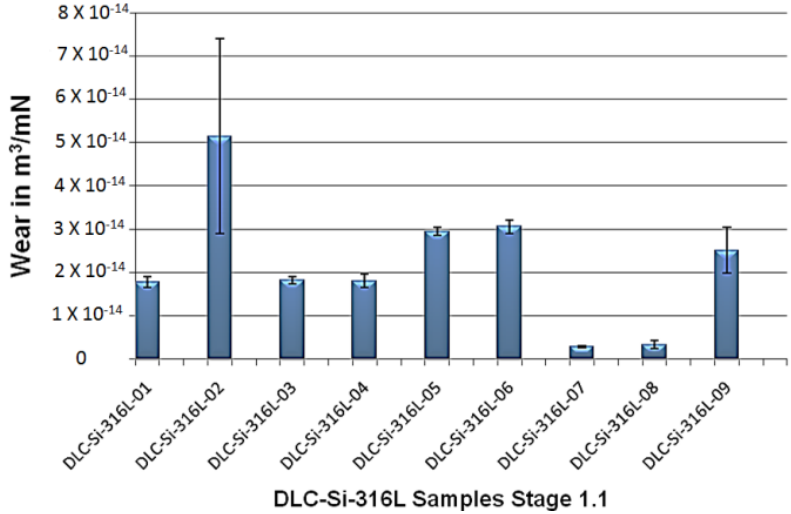
Figure 4. Variation in wear rates for DLC coatings with Si interlayers at varying bias voltage and gas